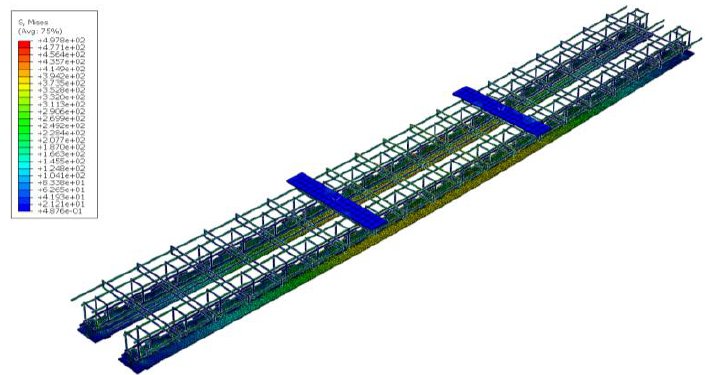
Fig. 8 . Relative plastic behaviour of rigid steel